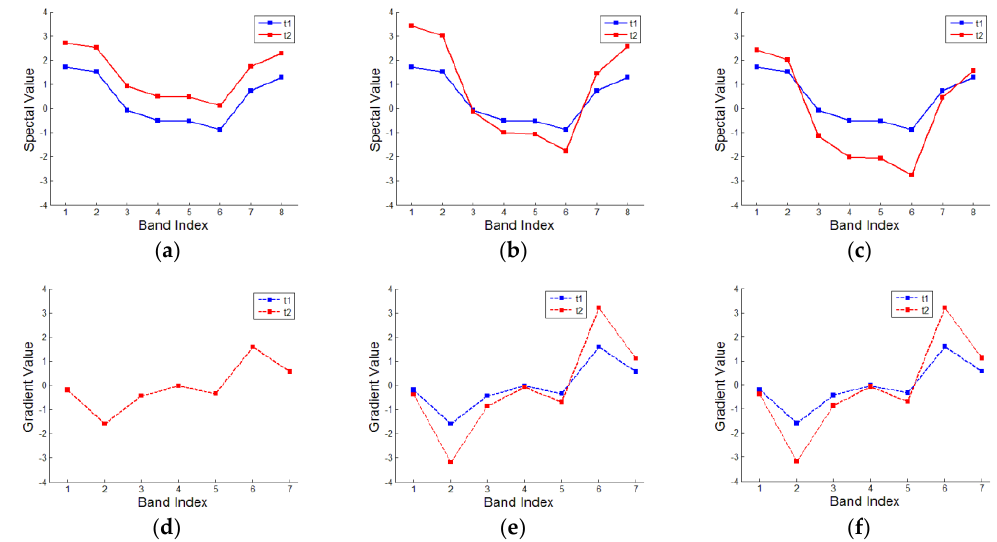
Figure 1. The simulated spectra of pseudo changes and the corresponding spectral gradients. ( a ) Spectral difference caused by an additive factor; ( b ) spectral difference caused by a multiplicative factor; ( c ) spectral difference caused by a multiplicative factor and an additive factor; ( d ) the spectral gradients of two spectral curves in Figure 1a (the two curves coincide); ( e ) the spectral gradients of two spectral curves in Figure 1b; ( f ) the spectral gradients of two spectral curves in Figure 1c.